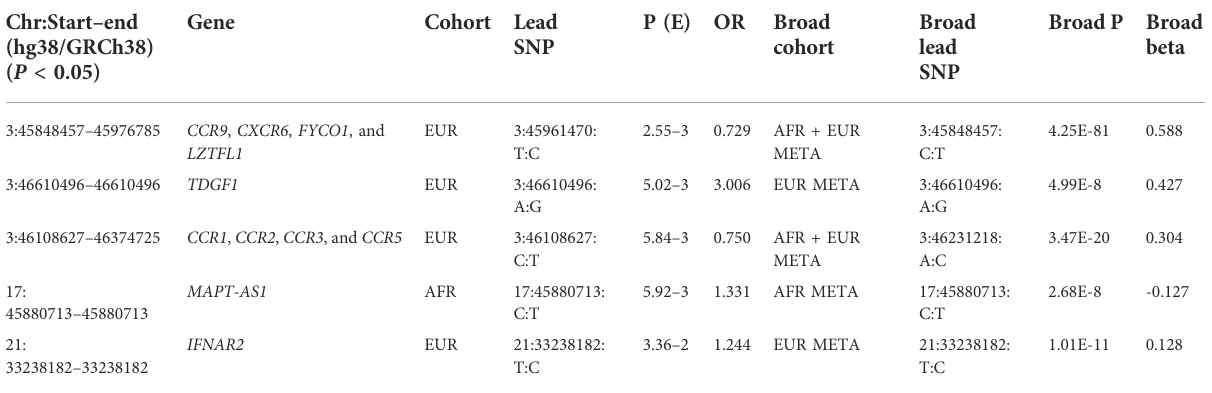
TABLE 2 Replication of previous fi ndings.